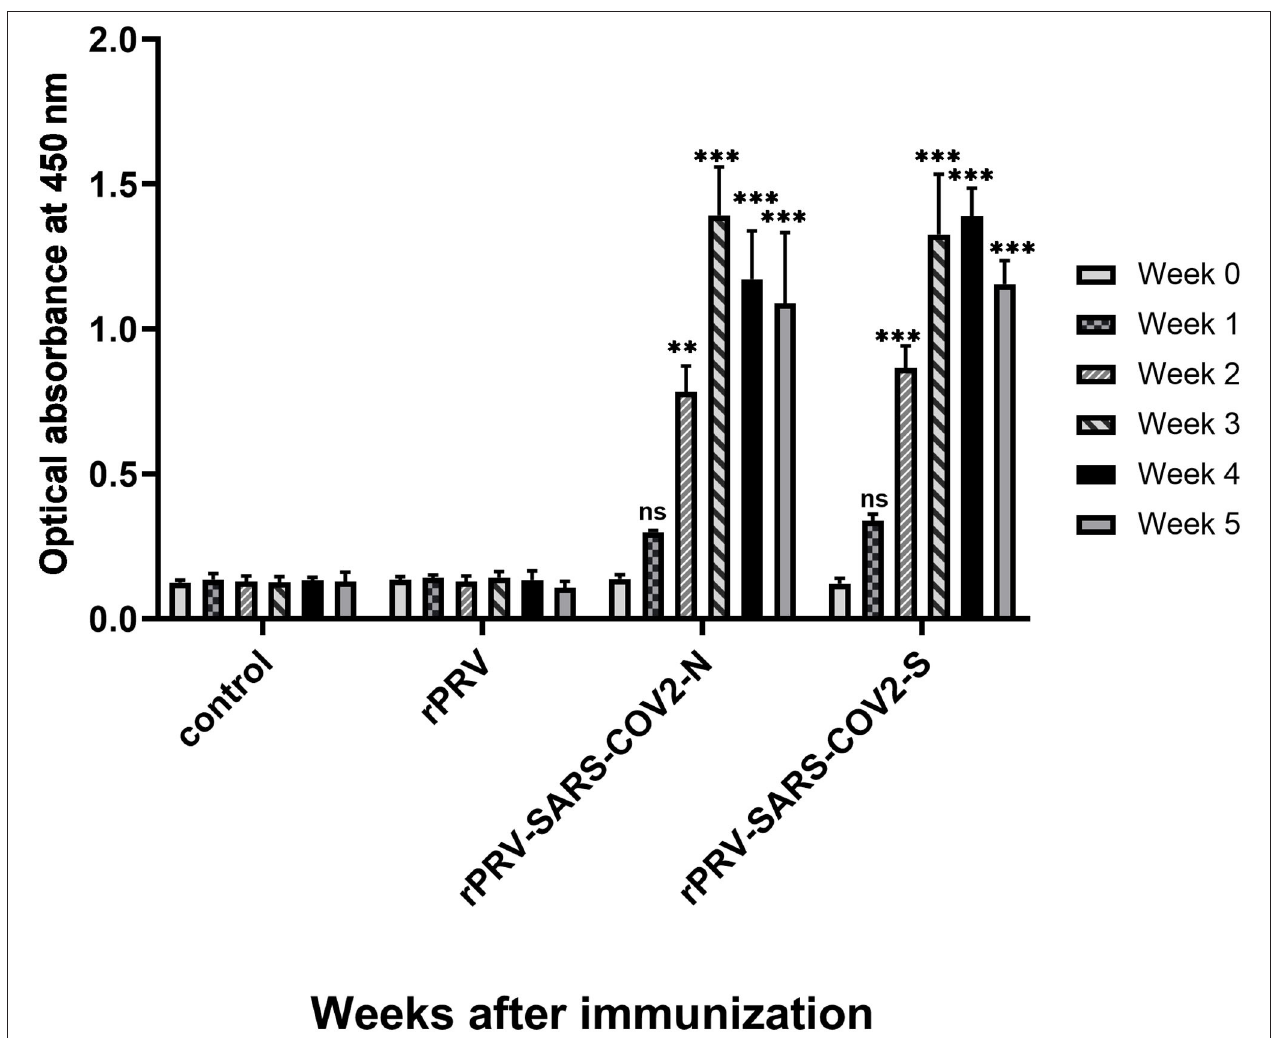
FIGURE 8 | Total IgG level of mice immunized detection by I-ELISA. Compared with the control group (PBS group), total IgG levels in groups rPRV-SARS-CoV-2-S and rPRV-SARS-CoV-2-N increased significantly ( P < 0.001) after week 2, but there was no significant change in rPRV group. ** and *** represented P value ≤ 0.01 and P value ≤ 0.001, respectively.